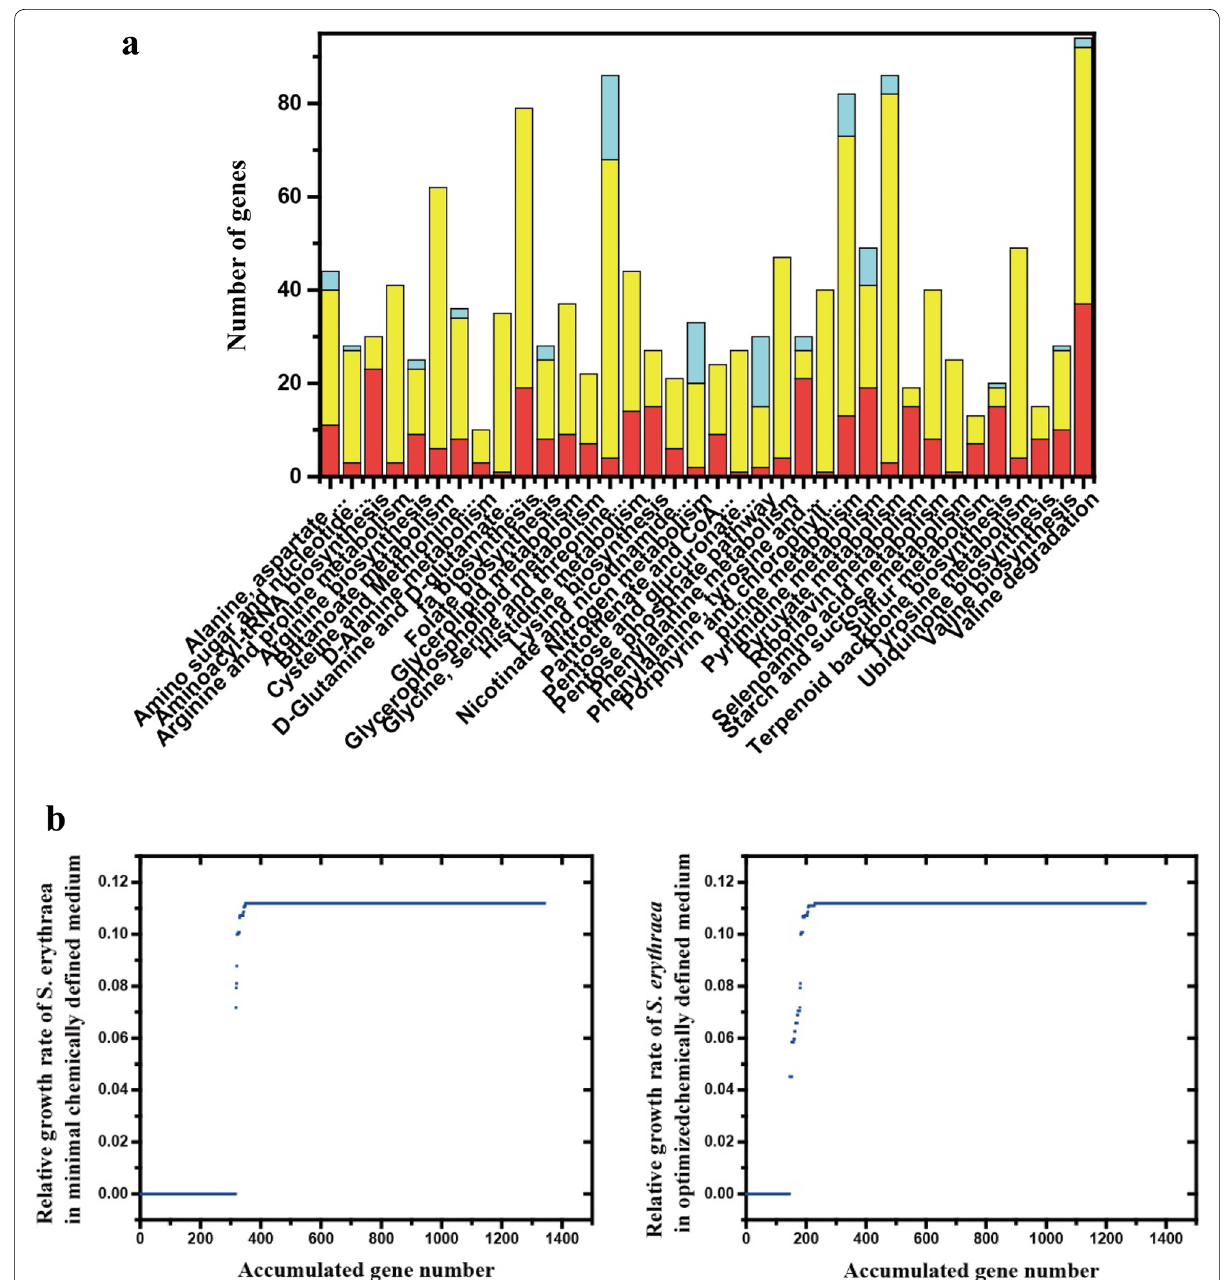
Fig. 6 Results of single-gene deletion research with iZZ1342. a The gene expression data and the categories of the expressed gene in KEGG with iZZ1342 (red is the necessary gene, blue is the semi-essential gene, and yellow is the non-essential gene). b The relative growth rate changes of S. erythraea between minimal chemically defined medium and optimized chemically defined